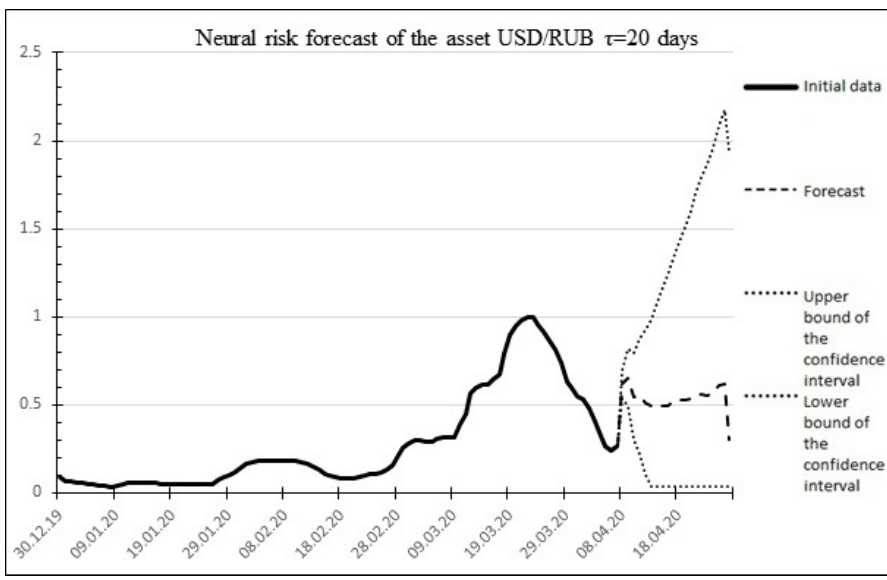
Figure 11. Neural asset risk forecast. Method: The aggregate forecast of the systematic risk of the asset F Σ